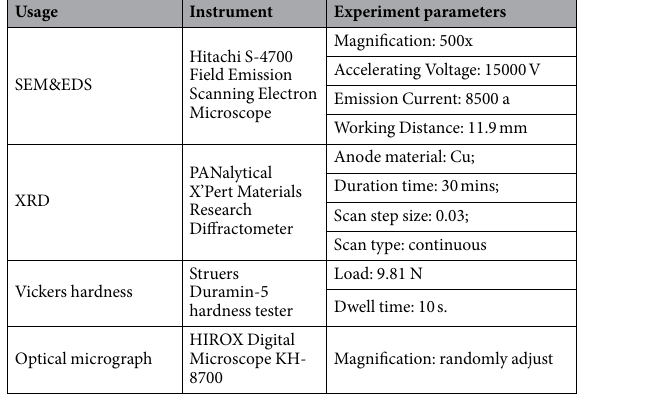
Table 5. The instruments used for characterization or